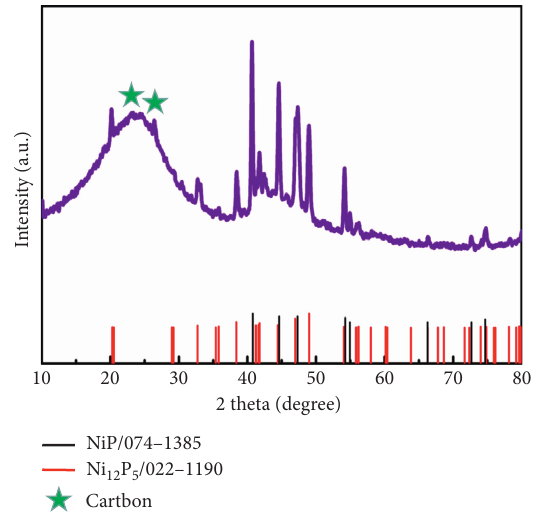
Figure 3: XRD patterns of Ni